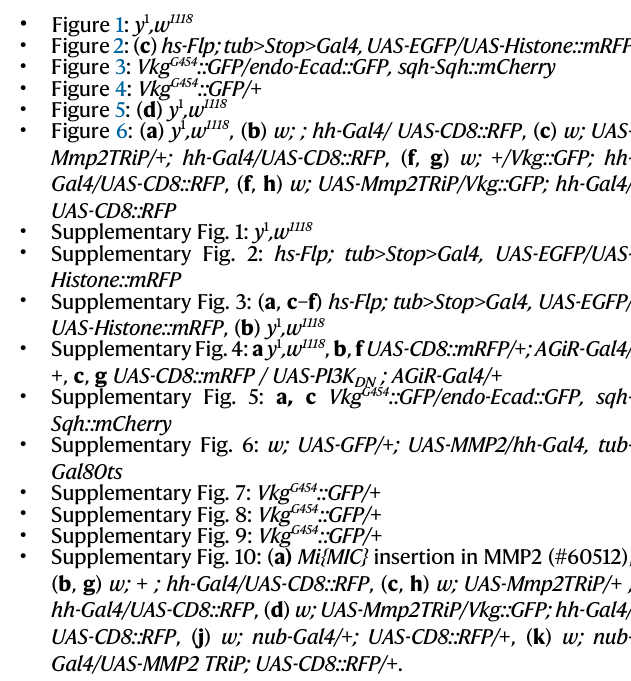
(cid:129) Figure 1: y 1 ,w 1118 (cid:129) Figure2:( c ) hs-Flp;tub>Stop>Gal4,UAS-EGFP/UAS-Histone::mRFP (cid:129) Figure 3: Vkg G454 ::GFP/endo-Ecad::GFP, sqh-Sqh::mCherry (cid:129) Figure 4: Vkg G454 ::GFP/+ (cid:129) Figure 5: ( d ) y 1 ,w 1118 (cid:129) Figure 6: ( a ) y 1 ,w 1118 , ( b ) w; ; hh-Gal4/ UAS-CD8::RFP , ( c ) w;